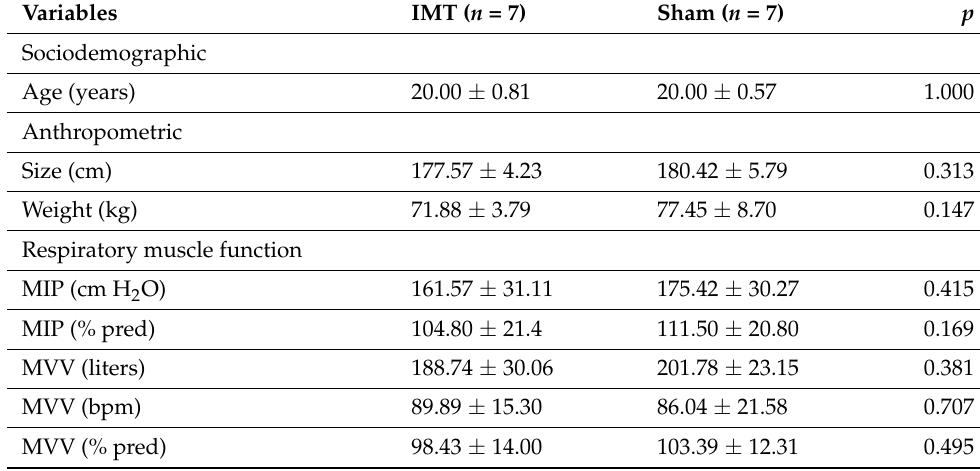
Table 1. General characteristics of the participants ( n = 14) at